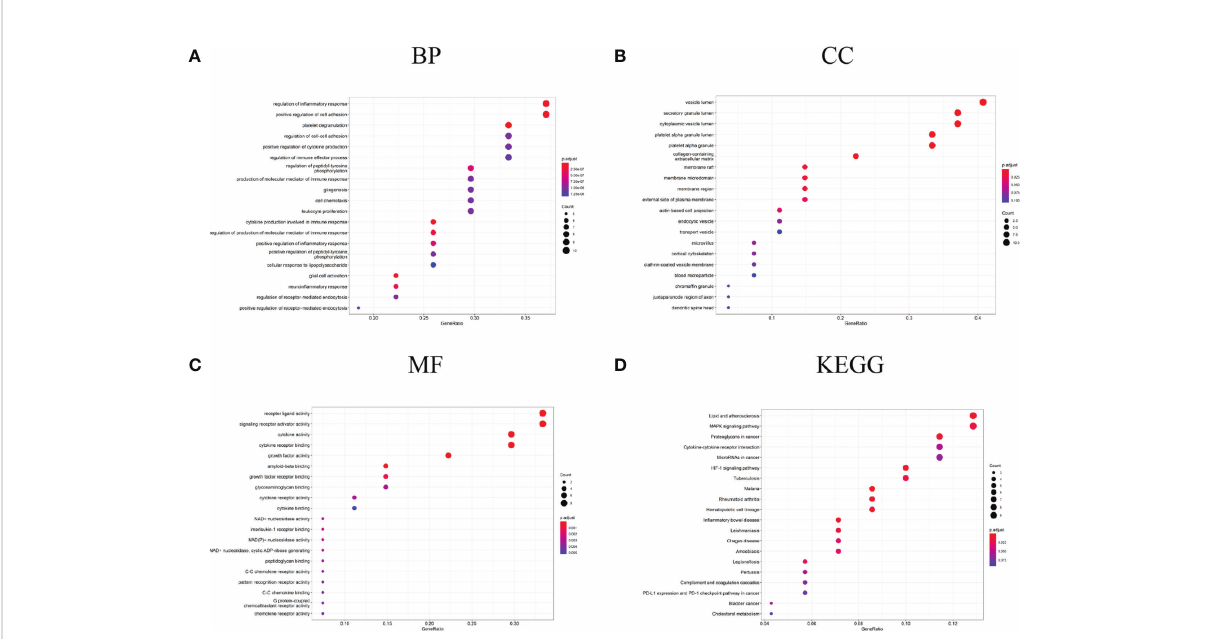
FIGURE 4 GO and KEGG analysis results of DEGs. (A) GO biological process enrichment results; (B) GO cell component enrichment results; (C) GO molecular function enrichment results; (D) KEGG pathway enrichment results. GO: gene ontology. KEGG: Kyoto Encyclopedia of Genes and Genomes.